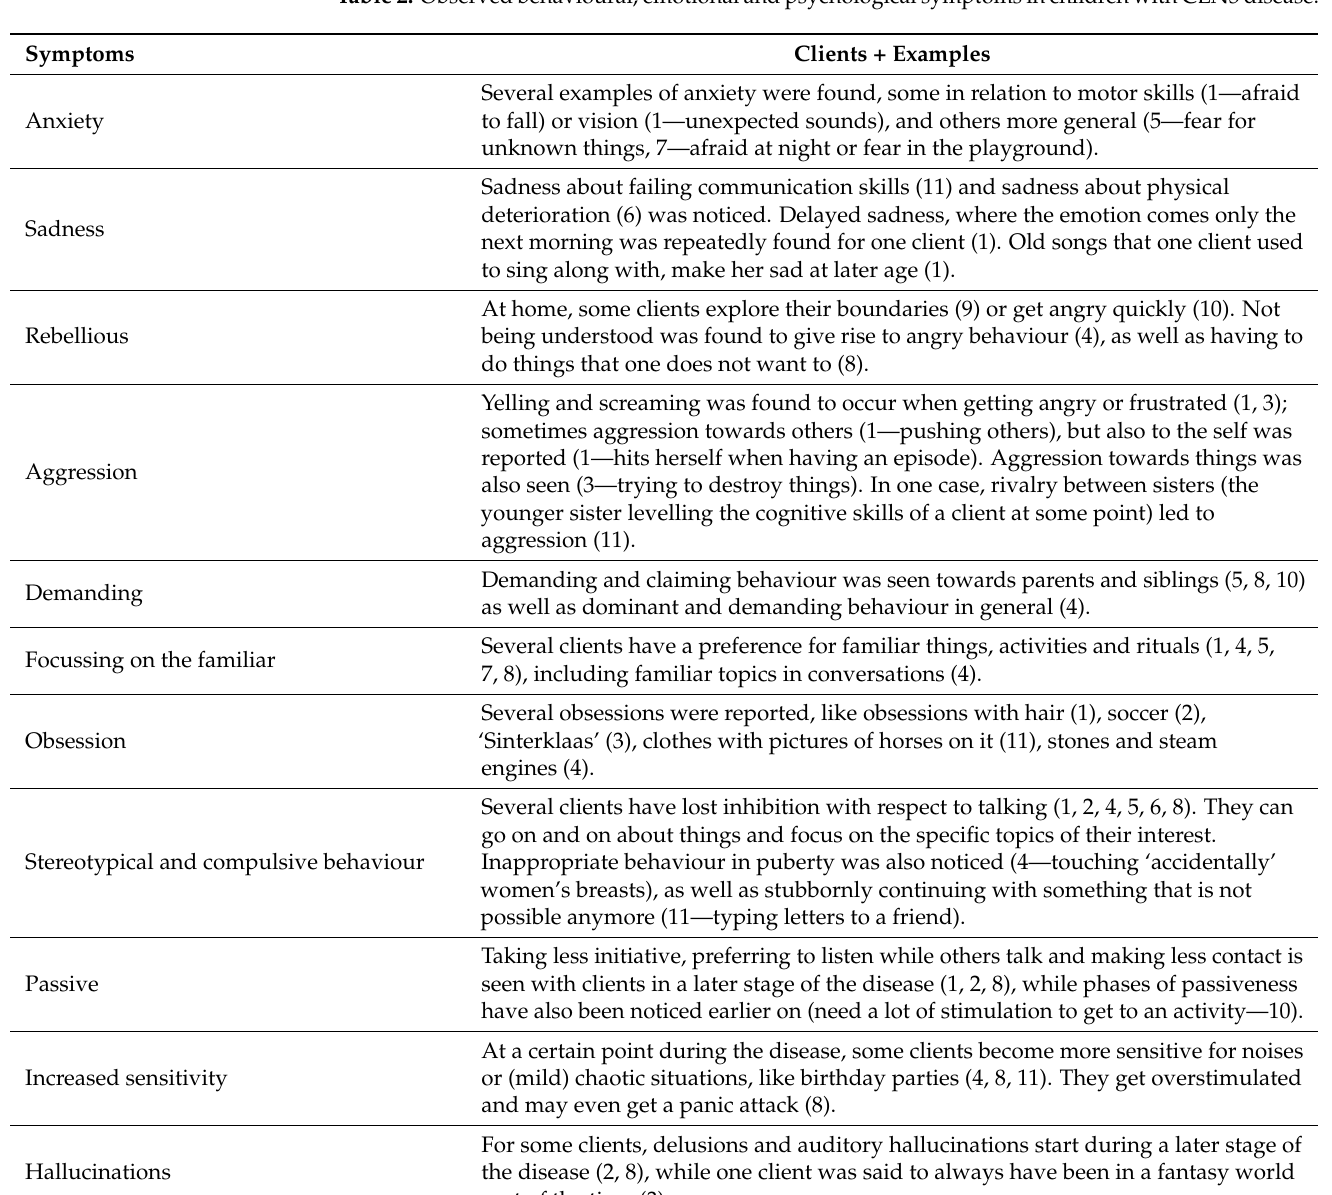
Table 2. Observed behavioural, emotional and psychological symptoms in children with CLN3